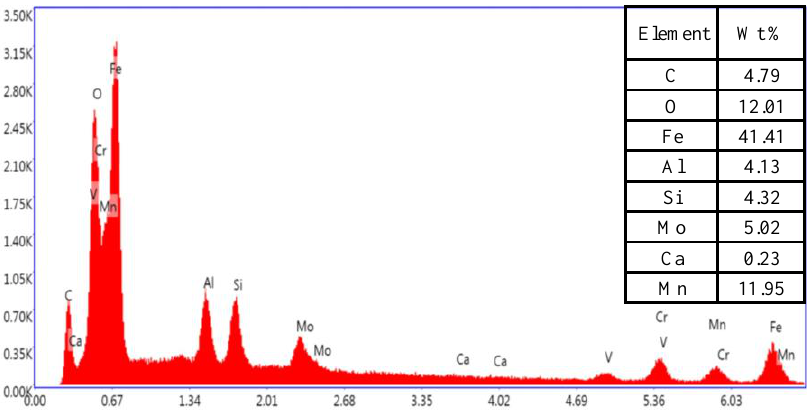
Figure 11. Energy-dispersive spectrum (EDS) profiles of the inclusion in WM marked in Figure 10d.